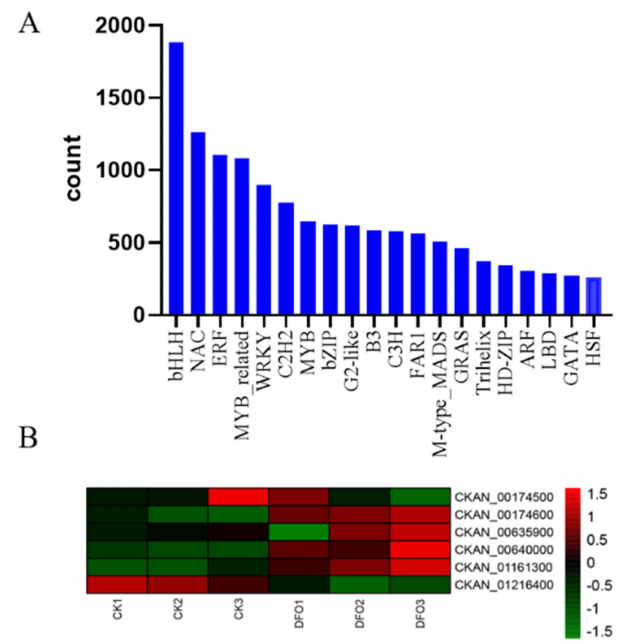
Figure 6. Transcription factor family analysis of DFO − induced transcriptional changes in C. camphora . ( A ) Quantitative statistics of transcription factor proteins and ( B ) the expression profile of transcription factors related to iron transport regulation. The bar represents the scale of the expression levels for each gene (FPKM) in the different treatments, as indicated by green/red rectangles. Genes in red show upregulation, and those in green show downregulation.